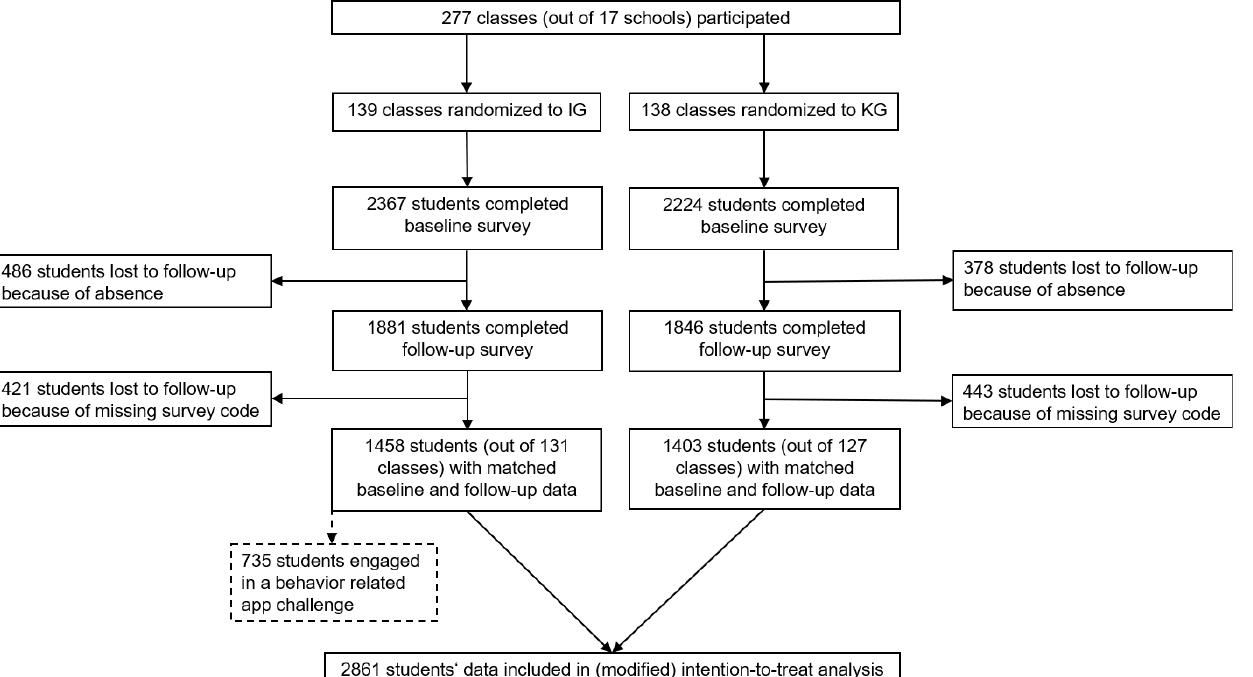
Figure 1. Participants flow chart.